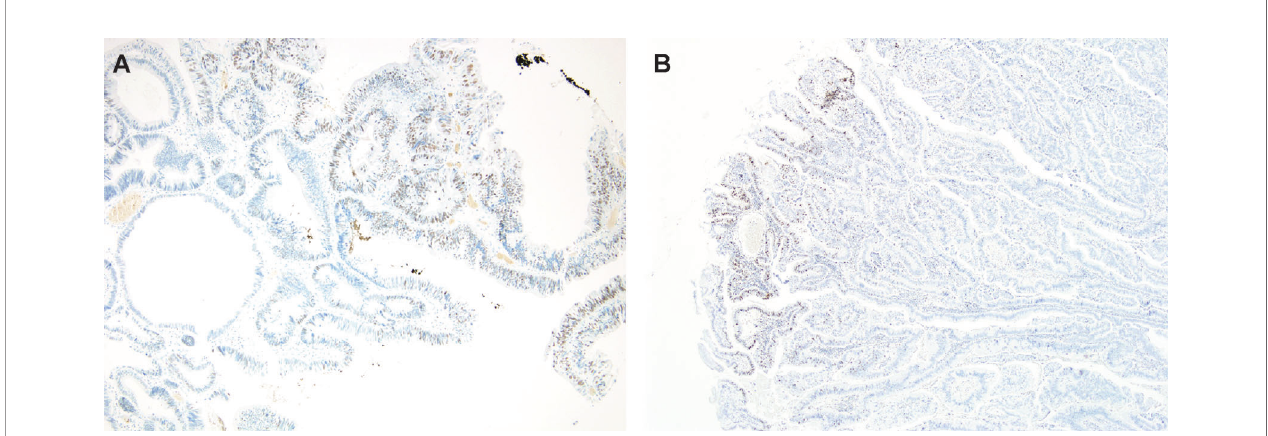
FIGURE 4 | Heterogeneity of MMR protein immunolabeling. Loss of (A) MSH2 protein (left panel, 100×), and (B) MSH6 protein (right panel, 100×) with intact MMR proteins in another area of the same slide.